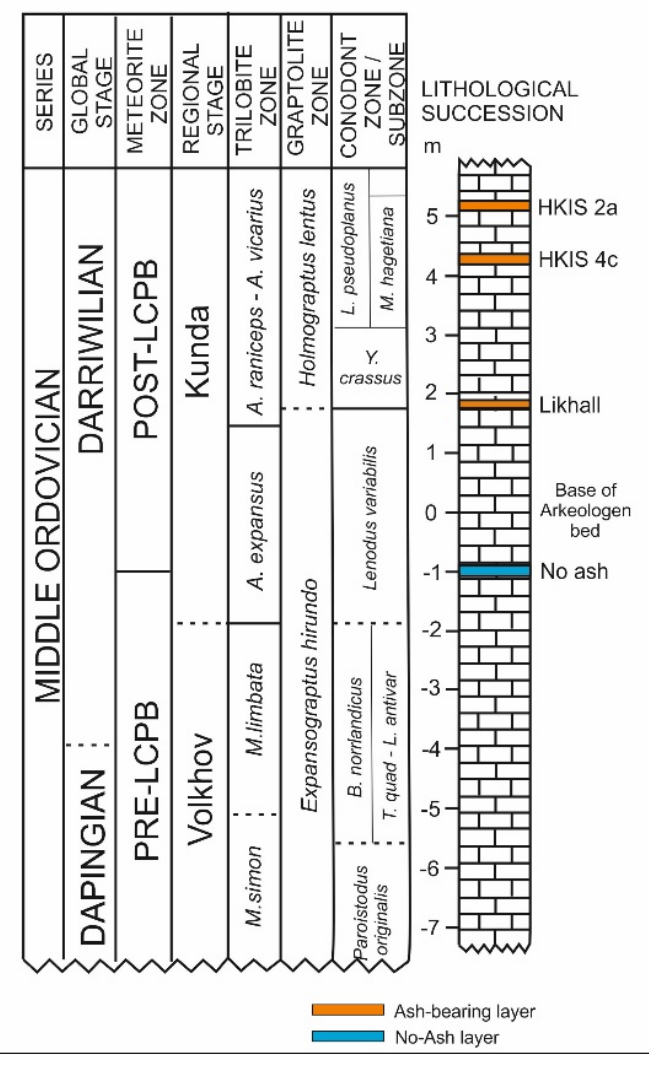
Figure 1. Stratigraphic column.